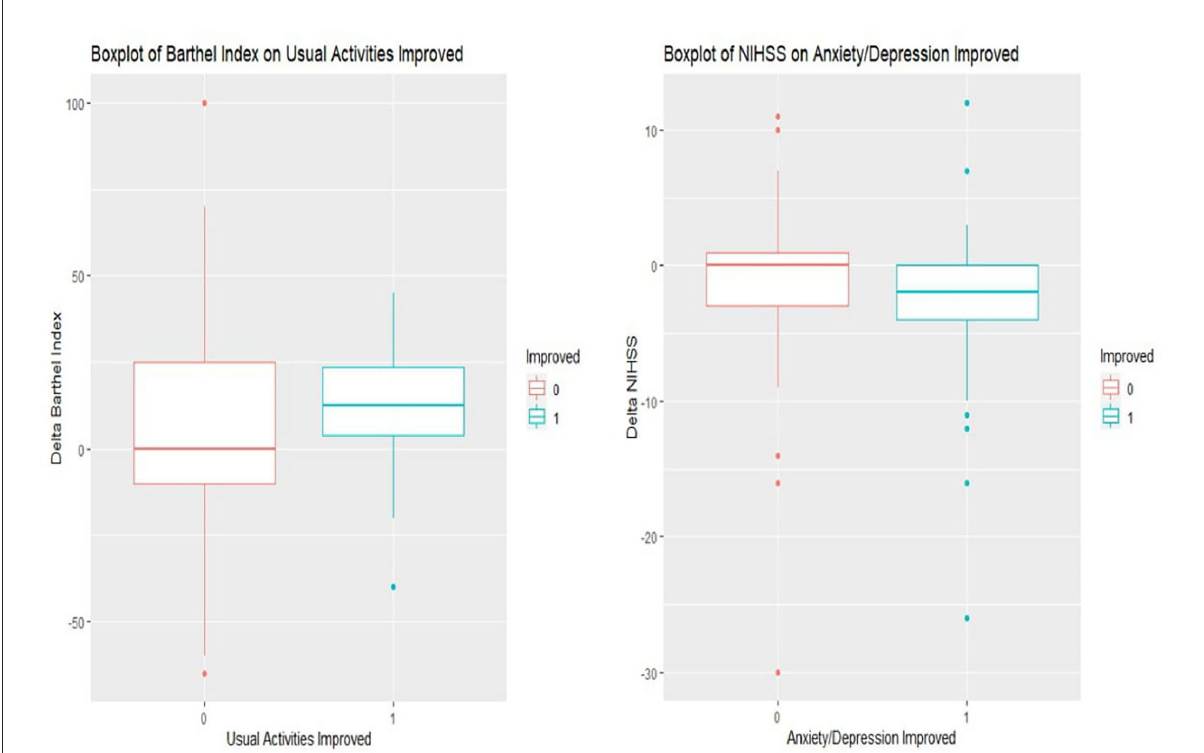
FIGURE2 Boxplots of important domains of EQ-5D associated with NIHSS and Barthel Index scorings. In Barthel Index (left side of boxplot) (with usual activities improvement labeled as 1 and non-improvement as 0), it shows that patients with improved usual activities have a better Barthel Index than their counterparts after post-acute care rehabilitation (median of delta Barthel Index: 12.5 vs. 0.0, the more the better). In NIHSS (right side of boxplot) (with anxiety/depression improvement labeled as 1 while and non- improvement as 0), it reveals that patients with improved anxiety/depression show better NIHSS scorings than those without improvement (median of delta NIHSS: − 2.0 vs. 0.0, the less the better). 1 Barthel Index = Discharge Barthel Index – Admission Barthel Index, > 0 defined as improved and, ≦ 0 defined as unimproved; 1 NIHSS = Discharge NIHSS – Admission NIHSS, < 0 defined as improved; ≧ 0 defined as